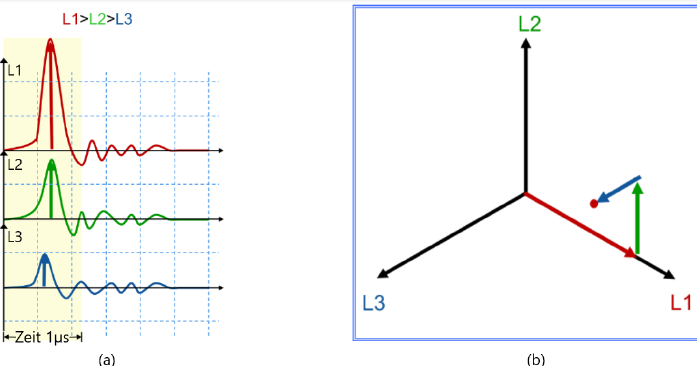
Figure 14. ( a ) Varying amplitudes in the three channels; ( b ) Vectors [38].